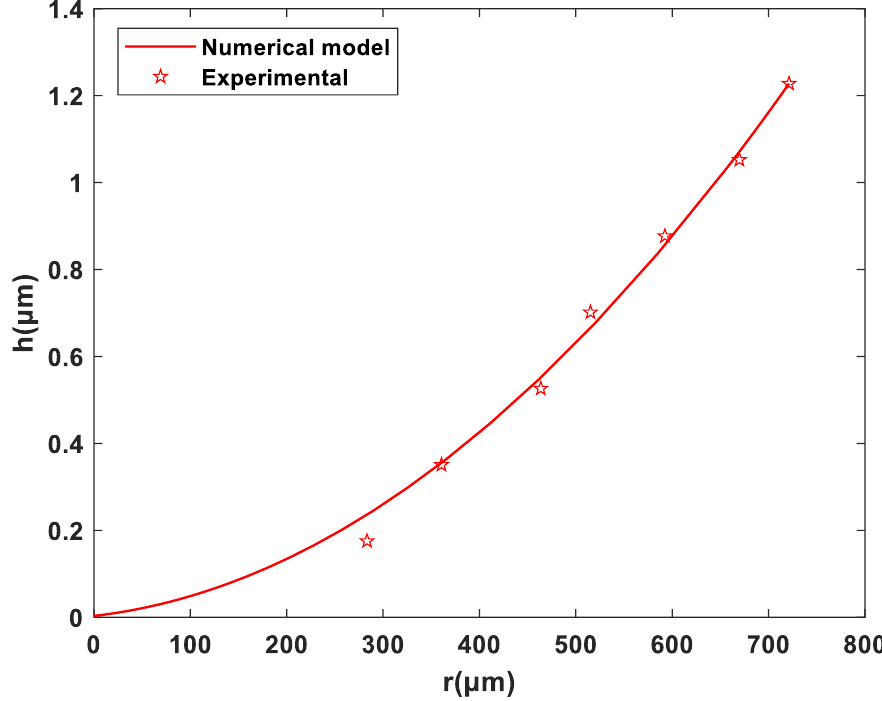
Figure 5. Comparison of the numerical model and experimental results based on film thickness at a time step of 3.9 ms [33,34].